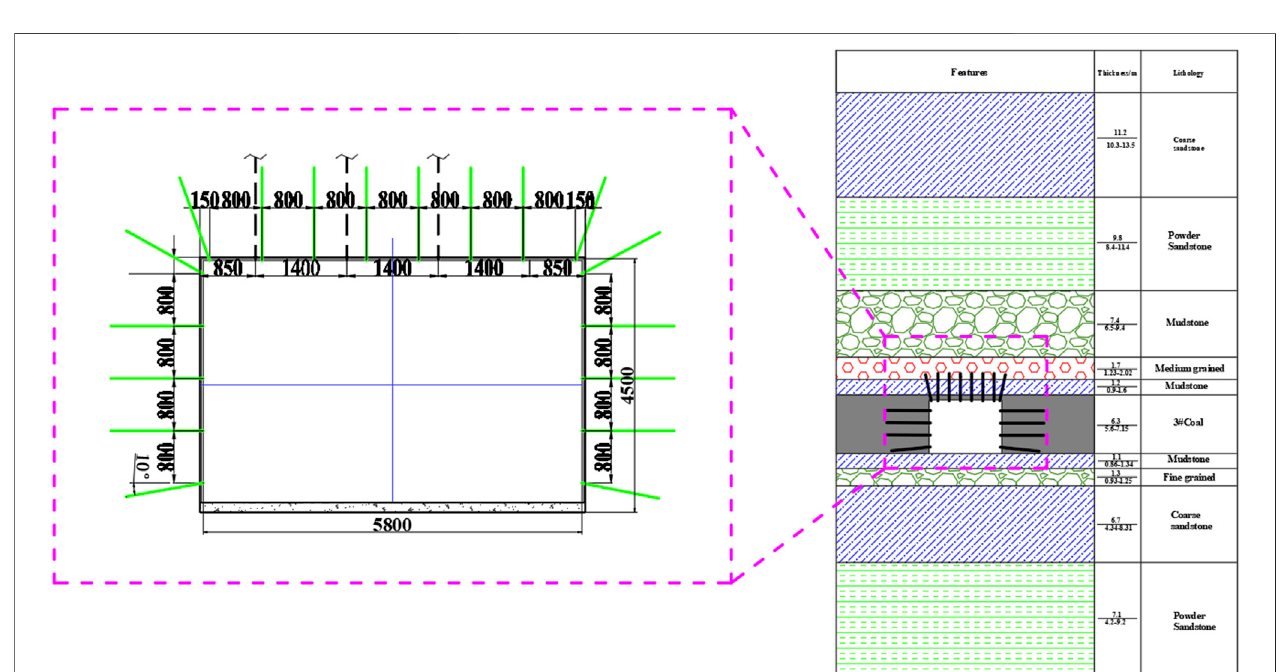
FIGURE 2 | Support scheme and generalized stratigraphic column of the shaft station.